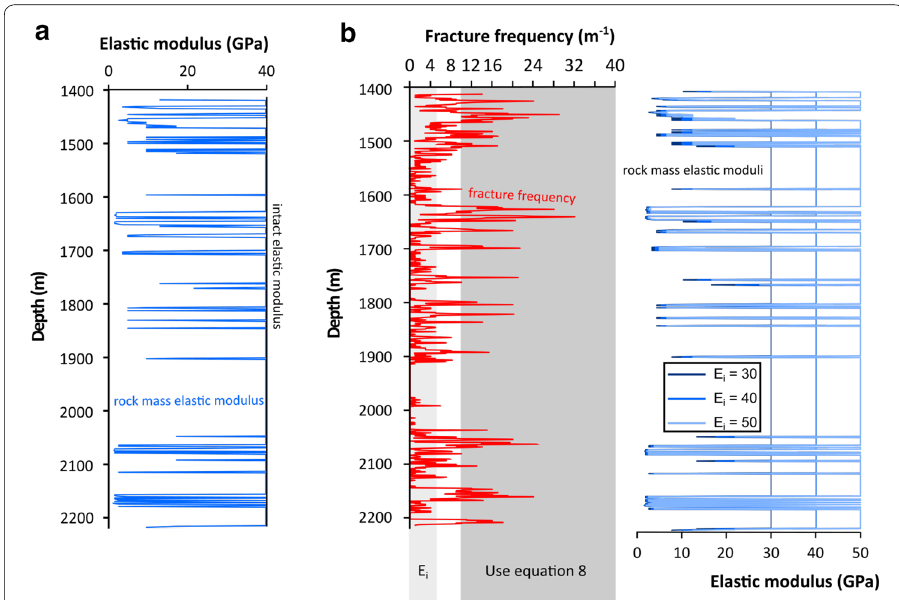
Fig. 9 Elastic modulus for EPS-1 over the depth interval 1400–2200 m; a comparison of intact elastic modulus ( E i 40 GPa) and rock mass elastic modulus (using Eq. 8) for E i = density and resulting rock mass elastic modulus for three different E i values (30, 40 and 40